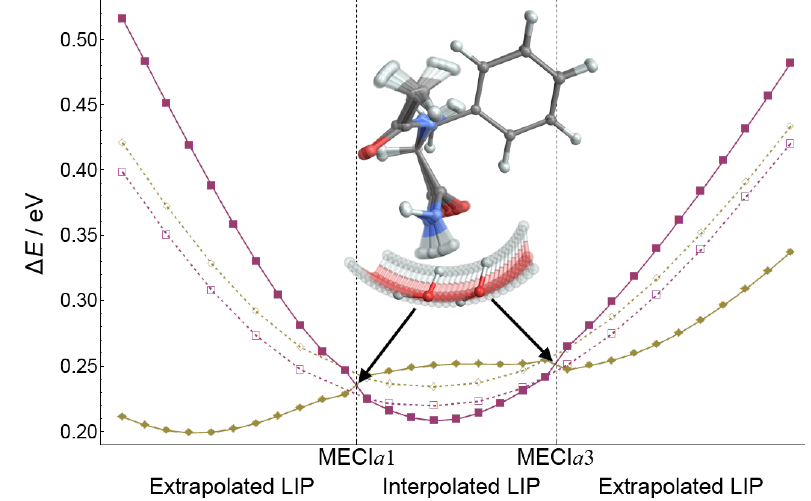
Figure 14. Splitting of degeneracy between ππ ∗ (bordeaux) and n π ∗ MECI a 1 and MECI a 3. The geometries on the interpolated and extrapolated part of the reaction path are shown in the inset. Energy profile (eV) of the reference CI seam